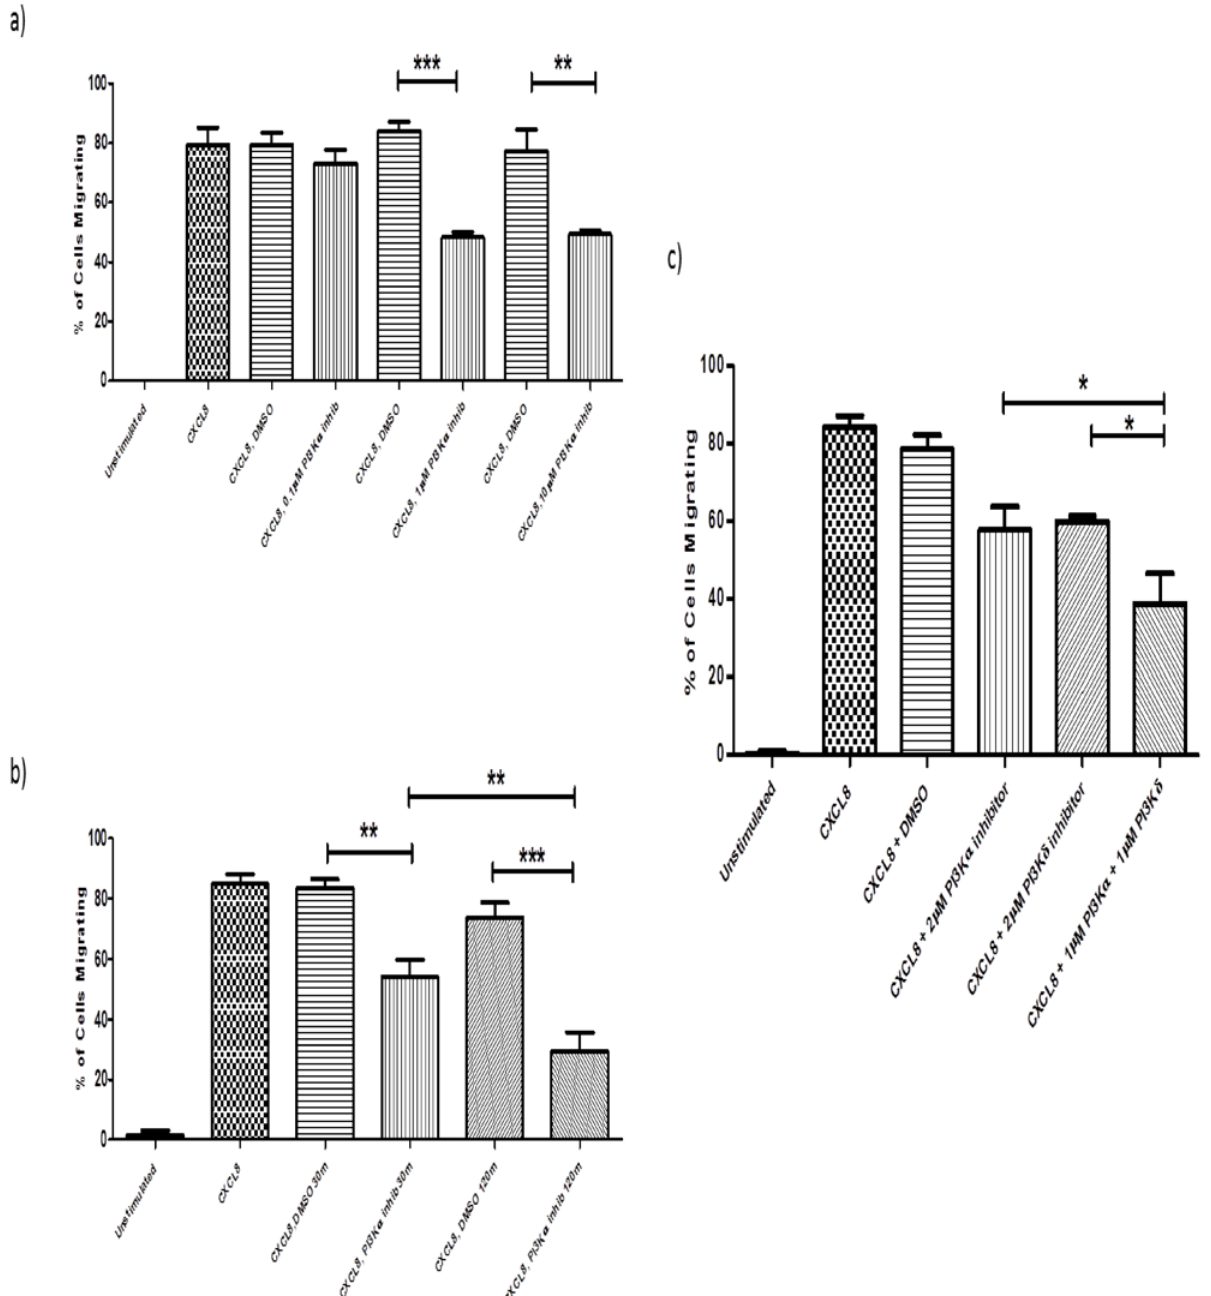
Fig 6. An antagonist of PI3K α inhibits CXCL8 induced chemotactic migration in a dose and time dependent manner. a) Neutrophils were pre-treated for 30 mins with varying concentrations (from 0.1 μ M to 10 μ M) of the PI3K α selective inhibitor PIK75, and then stimulated with 100ng/ml CXCL8 in the gradient assay. b) Neutrophils were pre-treated with 1 μ M of PIK-75 for 30 minutes or 2 hours, prior to construction of the migration gel and the addition of 100ng/ml of CXCL8 in the gradient assay. Results are shown as mean ± SEM; n = 4, except for CXCL8, 1 μ M and the corresponding DMSO control where n = 11 *** p < 0.001, ** p < 0.01. Antagonists of PI3K δ and α have additive effects on inhibition of CXCL8 mediated neutrophil chemotaxis. Neutrophils were pre-treated for 30 mins with either 2 μ M of the PI3K α selective inhibitor, PIK-75, 2 μ M of the PI3K δ selective inhibitor, PIK-274 or 1 μ M of each and then stimulated with 100ng/ml CXCL8. Results are shown as mean ± SEM (n = 4) * p < 0.05. (Fig.